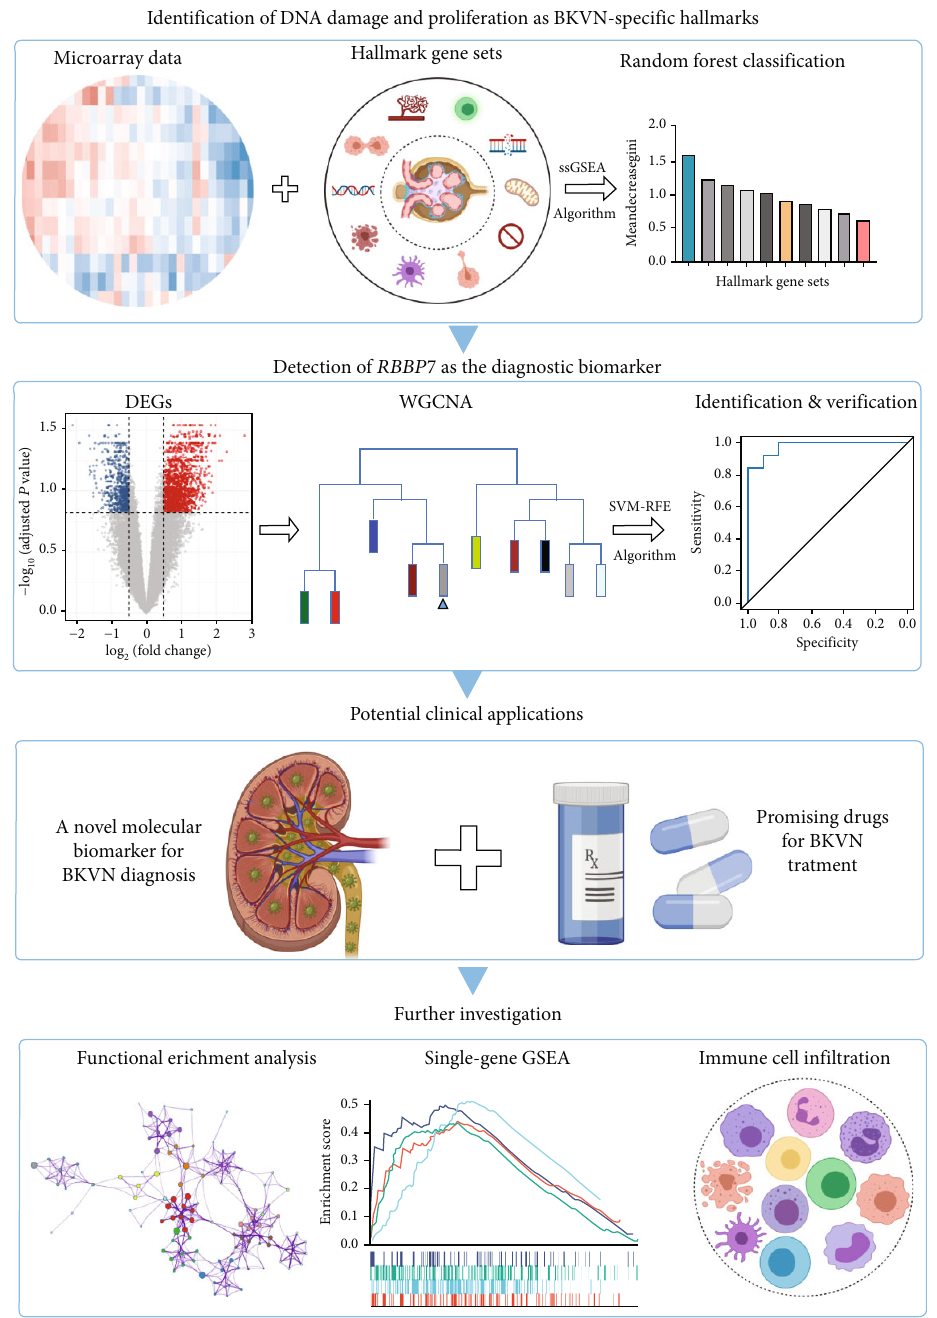
Figure 1: The main structure of the current study. BKVN: BK virus-associated nephropathy. ssGSEA: single sample gene set enrichment analysis. DEGs: di ff erentially expressed genes. WGCNA: weighted gene co-expression network analysis. SVM-RFE: support vector machine-recursive feature elimination. GSEA: gene set enrichment